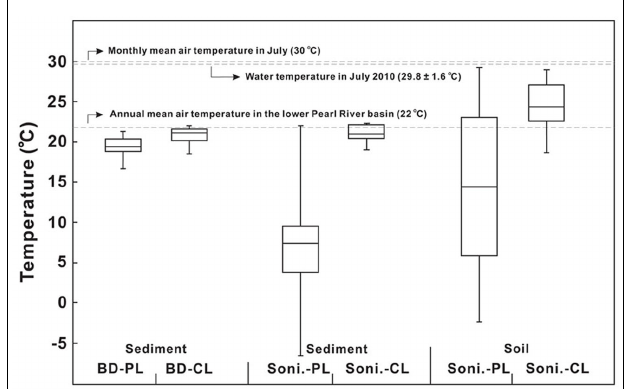
FIGURE 8 | Comparisons of MBT–CBT-derived temperatures from the sonication (Soni) and Bligh and Dyer (BD) methods to measured annual mean air temperature and monthly mean air temperatures of the lower Pearl River drainage basin, and water column temperature in the lower Pearl River and estuary. CL, core lipids; PL, polar